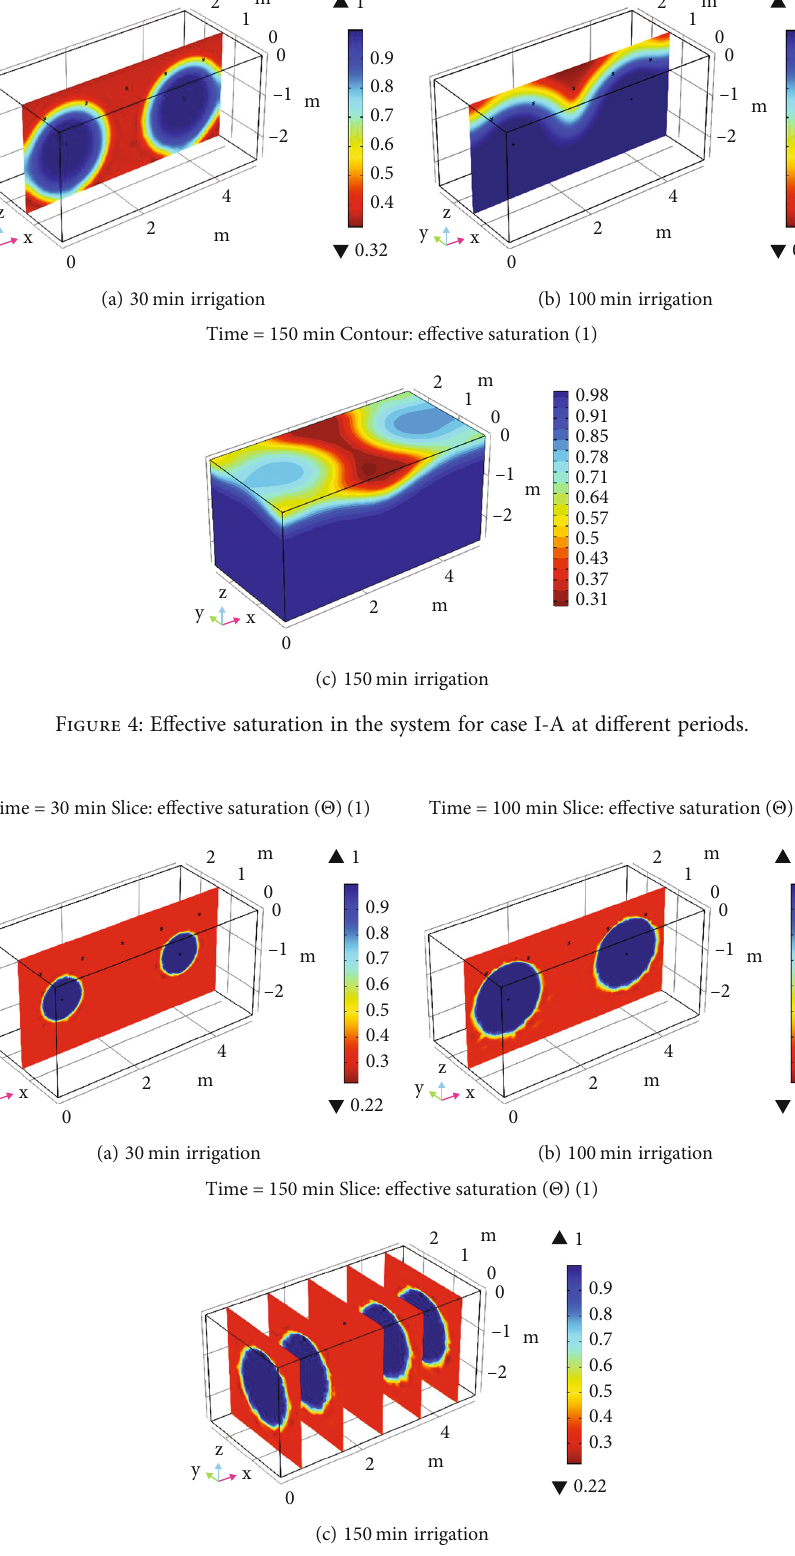
Figure 5: E ff ective saturation for case II-B at various time